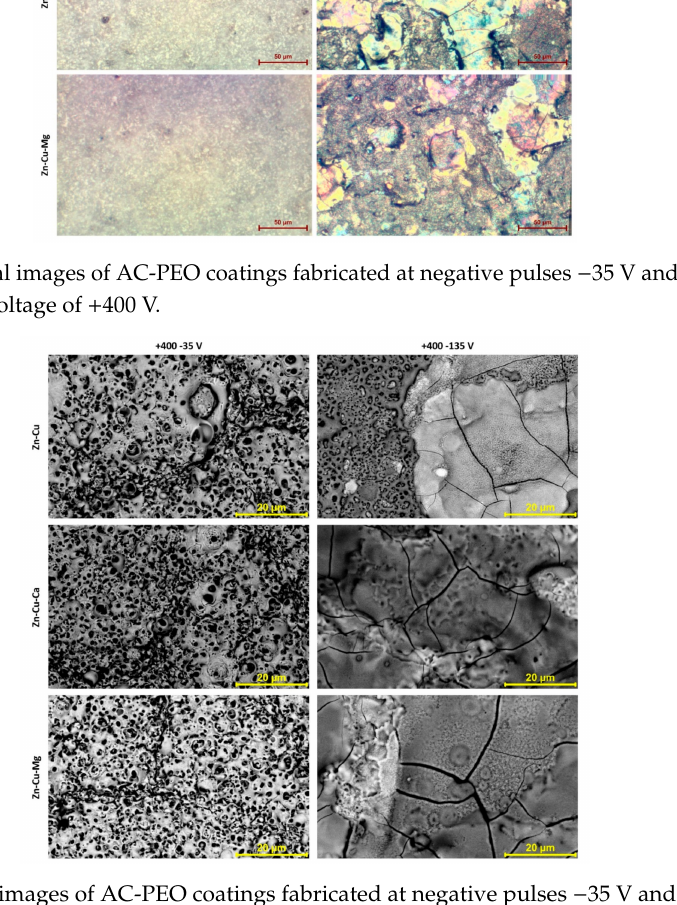
Figure 4. The SEM images of AC-PEO coatings fabricated at negative pulses − 35 V and − 135 V with the same positive voltage of + 400